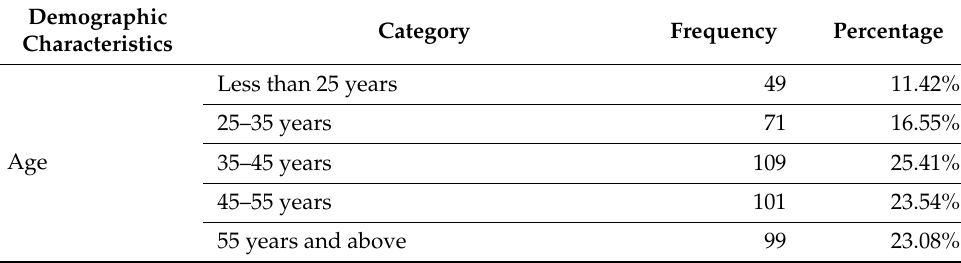
Table 1. Demographic Profile of the